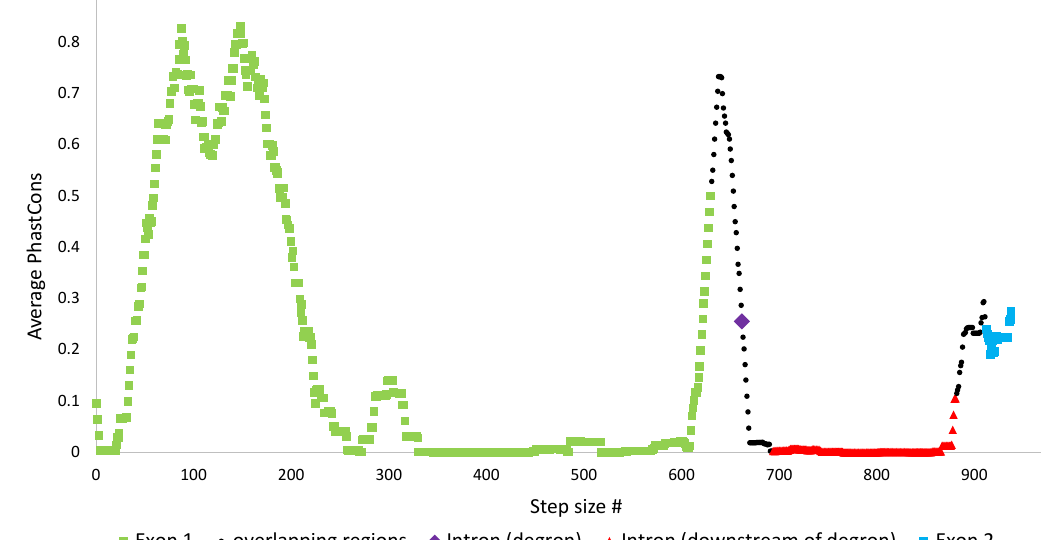
Figure 6. The averaged PhastCons scores for 32 nt segments spanning the entire S. cerevisiae HAC1 gene, with window size = 32 (length of the degron) and step size = 1. The scores were computed using 32 MUSCLE aligned complete HAC1 genes and with S. cerevisiae HAC1 as reference. Scores are color-coded by region, for segments that mapped entirely within exon 1 (green), degron (purple), rest of intron (red), and exon 2 (blue). In addition, average PhastCons scores of 32 nt segments whose sequences overlapped exon-intron junctions or degron-downstream intron sequence are colored in black.